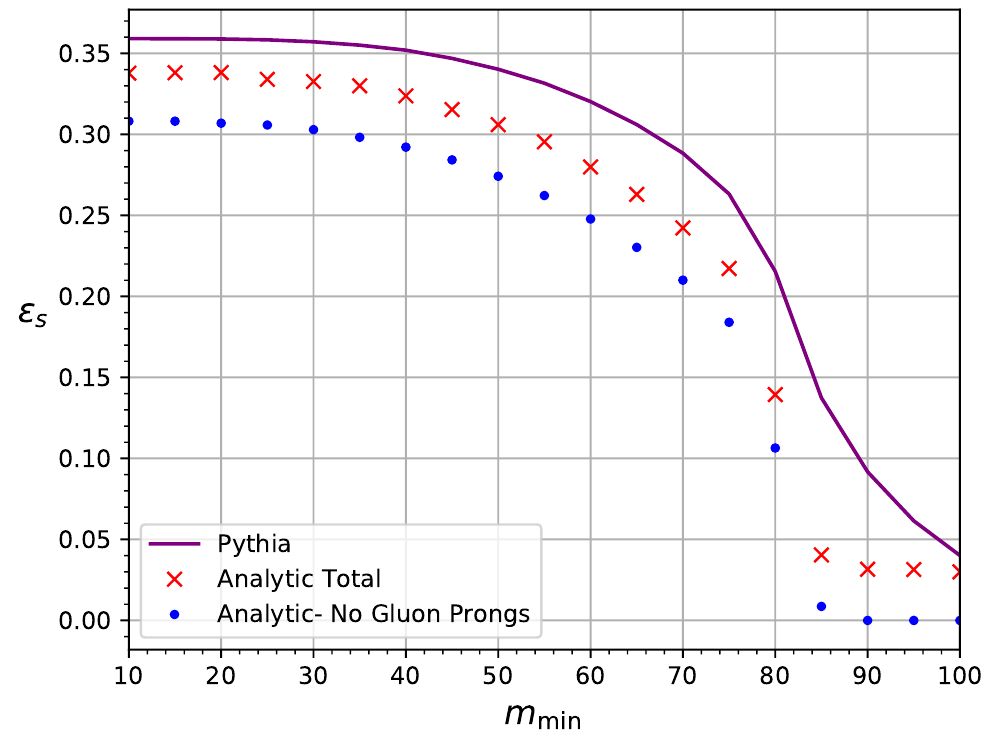
Figure 6. A comparison between different levels of approximation in analytical calculations and a Pythia simulation for top jets tagged with Y m -Splitter in a mass range 163 GeV < m < 225 GeV with ζ = 0 . 05 as a function of m min